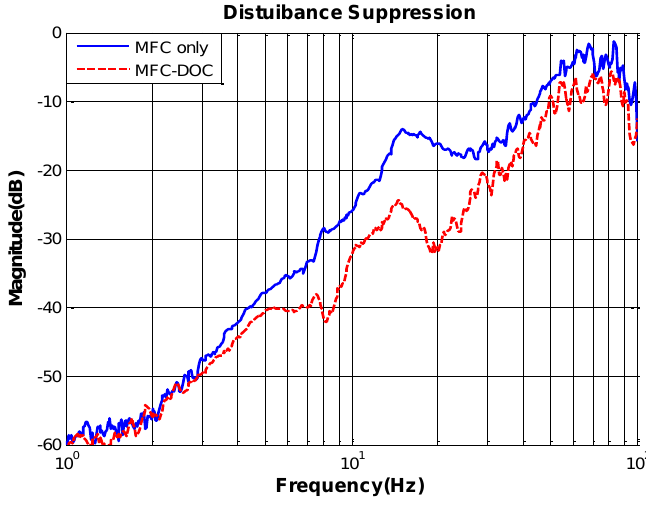
Figure 11. Disturbance suppression characteristics.